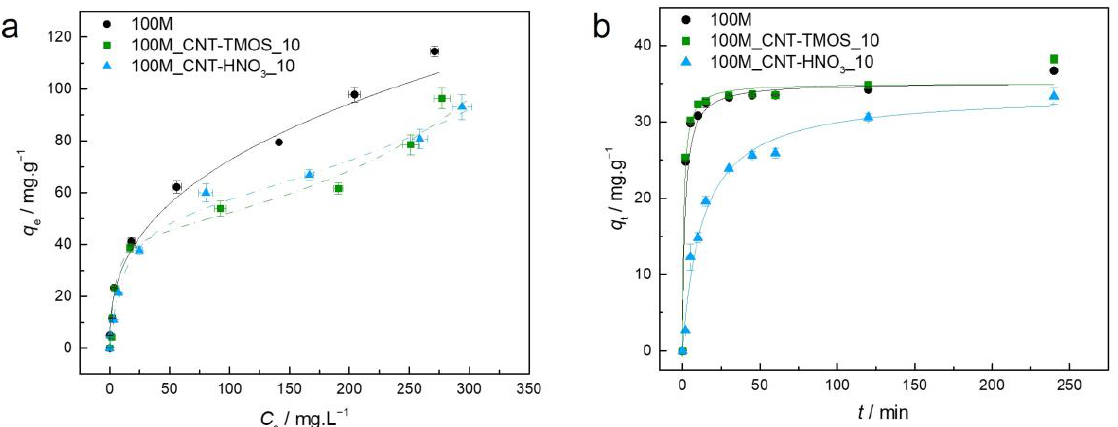
Figure 2. ( a ) — Experimental equilibrium data and the best fitted isotherm model for adsorption of benzene into the studied aerogels (solid line — Freundlich; dashed line — BET). ( b ) — Representative plots of the fit of nonlinearized form of pseudo-second order equation (solid line) to the data of experimental adsorption capacity as function of time, for the studied adsorbents towards benzene ( C 0 = 100 ppm, 15 rpm, 20 °C).